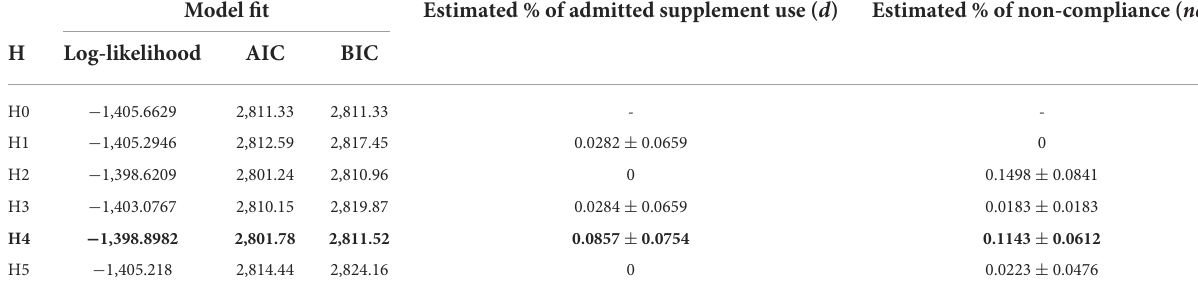
TABLE 7 Estimated use of herbal, mineral and/or vitamin supplements at PAG (12-month prevalence). Model